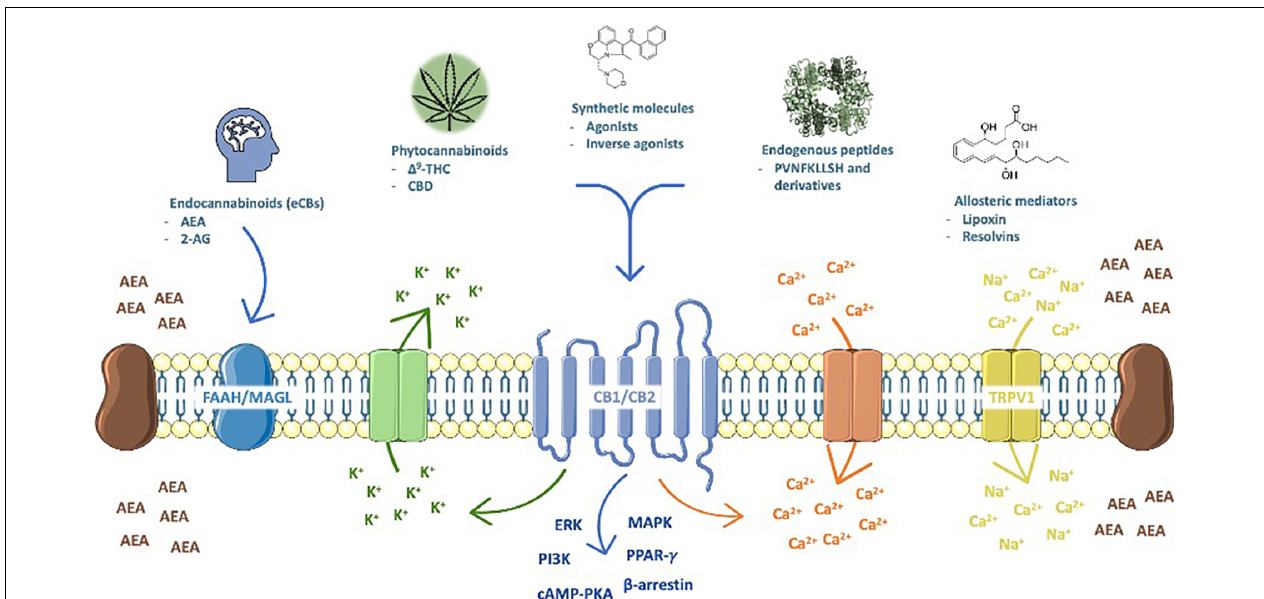
FIGURE 1 | The endocannabinoid system (ECS) is composed of lipid endocannabinoids (eCBs), allosteric (lipoxins and resolvins) and peptide (hemopressin derivatives) mediators, their receptors (the cannabinoid type 1 (CB1) and type 2 (CB2), which are activated by phyto- (THC, CBD, and possibly many others) and synthetic cannabinoids (represented by WIN55,212-2, a mixed agonist), metabolic enzymes (FAAH and MAGL, and others) and membrane transporters. Upon activation, CB1 and CB2 signal through fast (Ca 2 + and K + currents) and/or slow pathways, as cyclic AMP-protein kinase A (cAMP-PKA), ı extracellular signal-regulated (ERK), beta-arrestin, mitogen-activated protein kinase (MAPK) and PI3K; in addition, gene transcription is also turned on by nuclear receptors (PPAR γ and others).